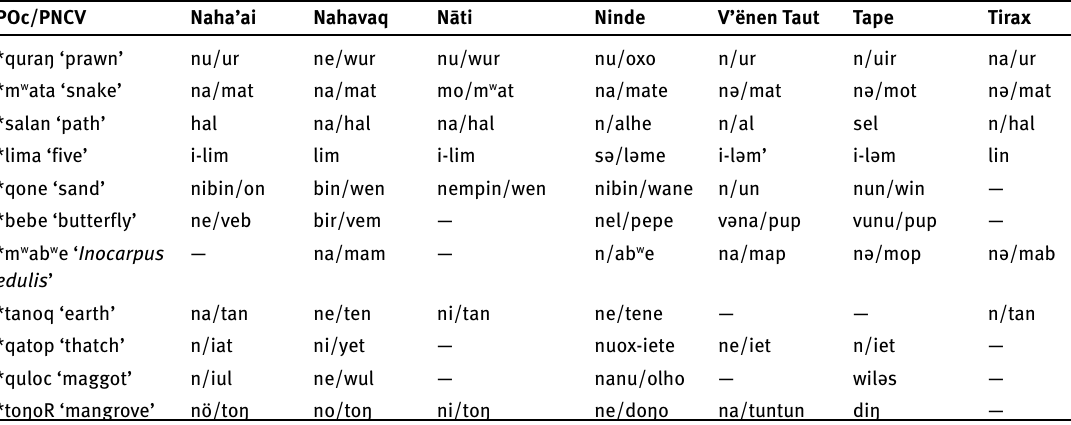
Table 7: Final vowels in Ninde and its neighbours/relatives.